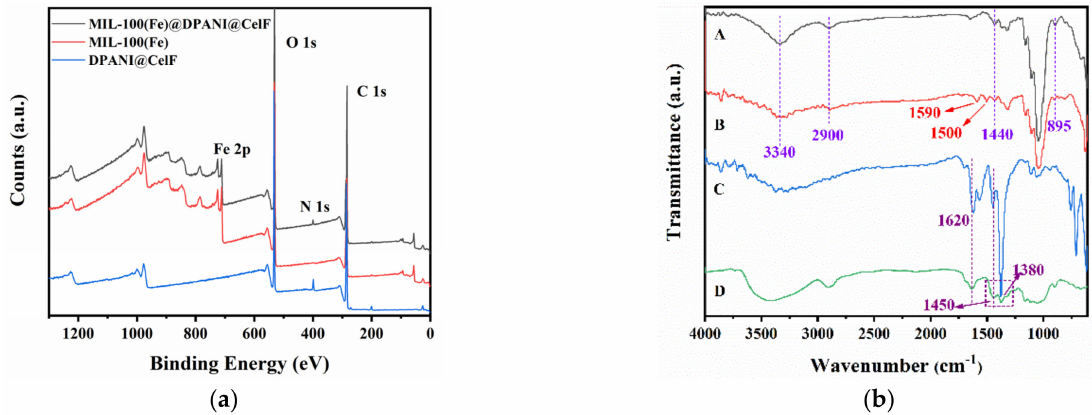
Figure 4. ( a ) XPS spectra of DPANI@CelF, MIL-100(Fe) and MIL-100(Fe)@DPANI@CelF; ( b ) FTIR spectra of CelF (A), DPANI@CelF (B), MIL-100(Fe)@DPANI@CelF (C) and MIL-100(Fe)